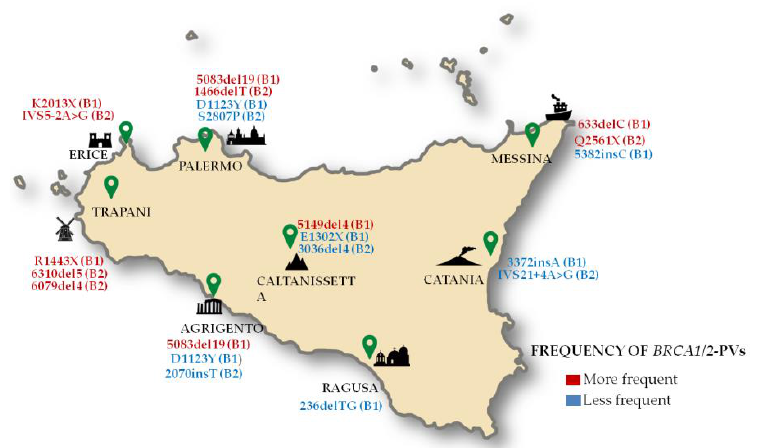
Figure 3. Geographical distribution of the hereditary breast/ovarian cancer families in Sicily.